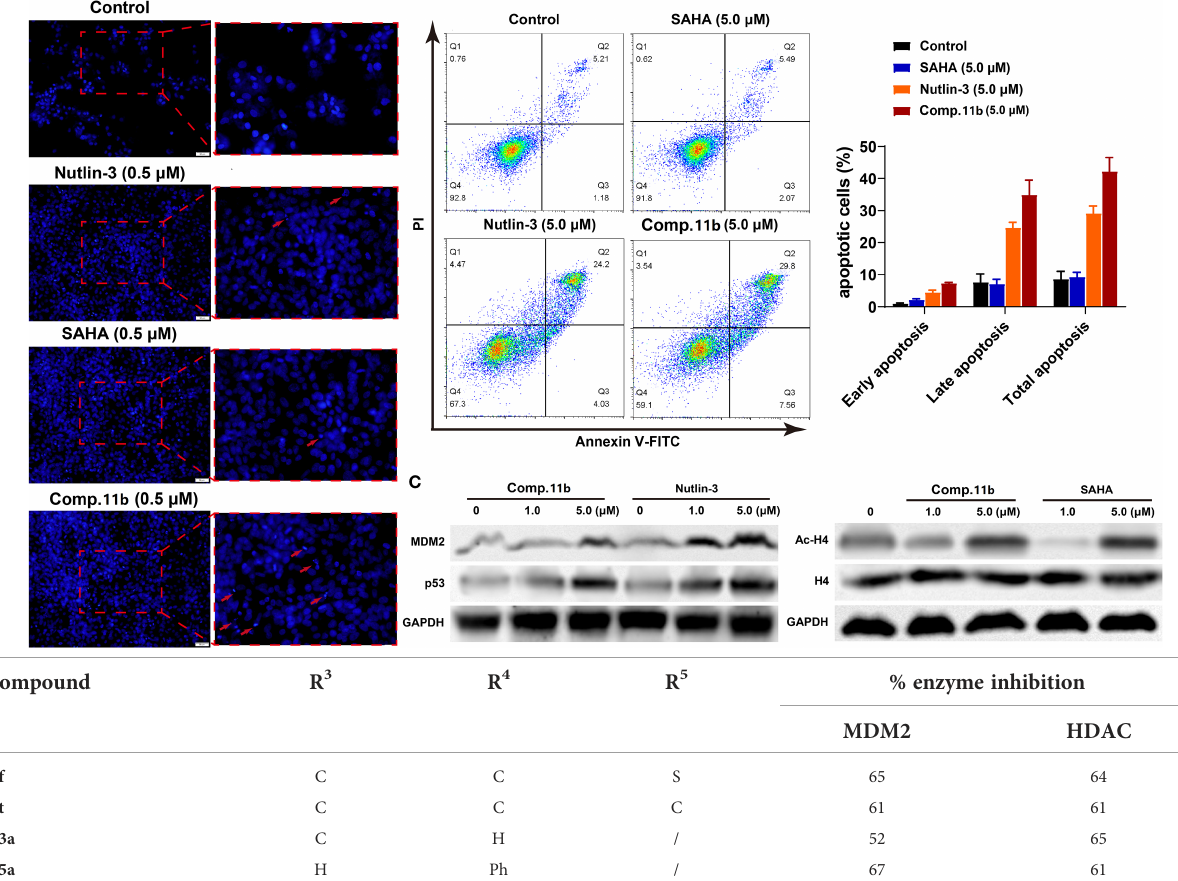
TABLE 2 Effects of amino acids 3 on enzyme